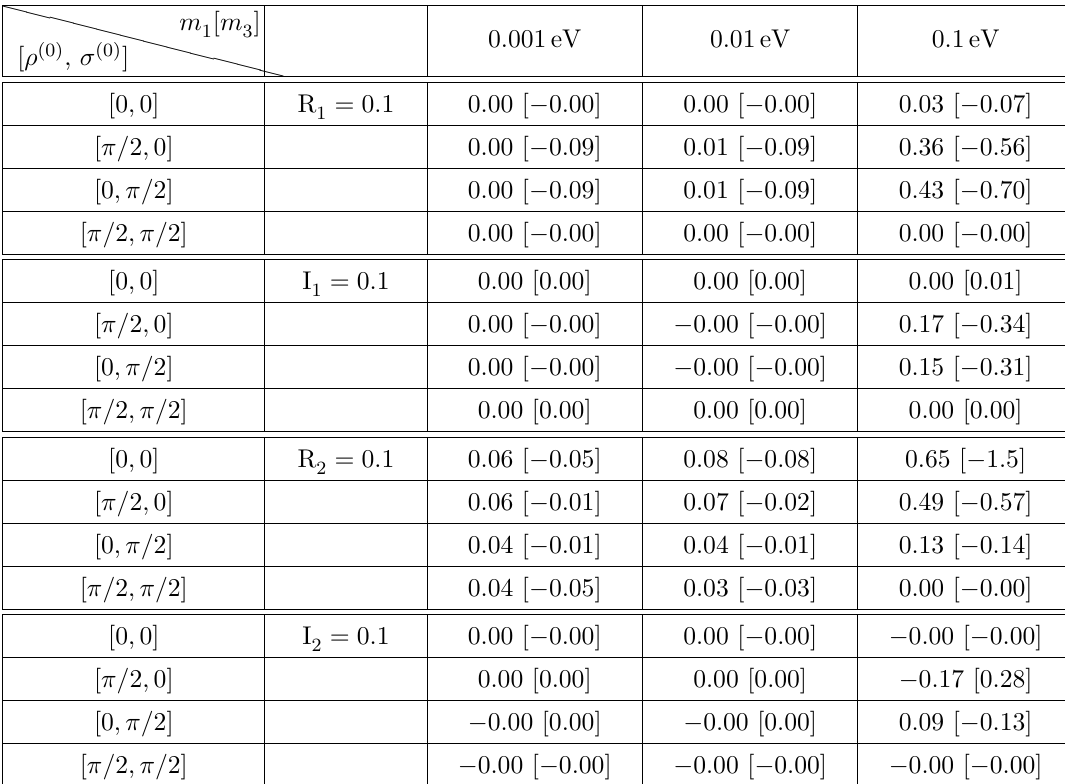
Table 1 . Some representative values of (cid:1) (cid:18) (induced by R respectively) at m (cid:26) (0) and (cid:27) (0) with (cid:14) (0) = (cid:0) (cid:25)= 2. sub-(cid:12)gure labelled by \NH + (cid:0) " in (cid:12)gure 1, (cid:1) (cid:14) takes a value of 10 at m